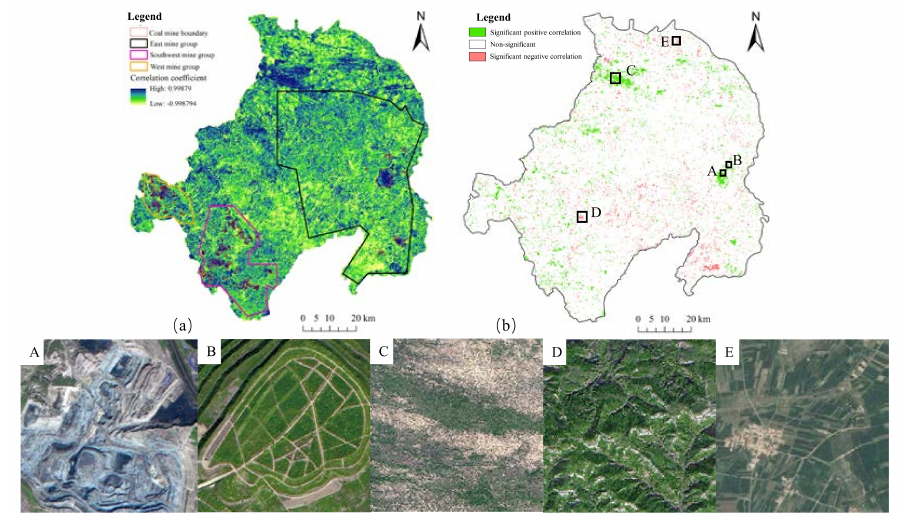
Figure 9. Spatial distribution of correlation ( a ) and significance ( b ) between ecological stability of the coal mining area and NDVI in Jungar Banner (A, Coal mine excavation damage area; B, Reclamation area; C, Natural area in the plain region; D, Natural area in loess hilly region; E, Cultivated